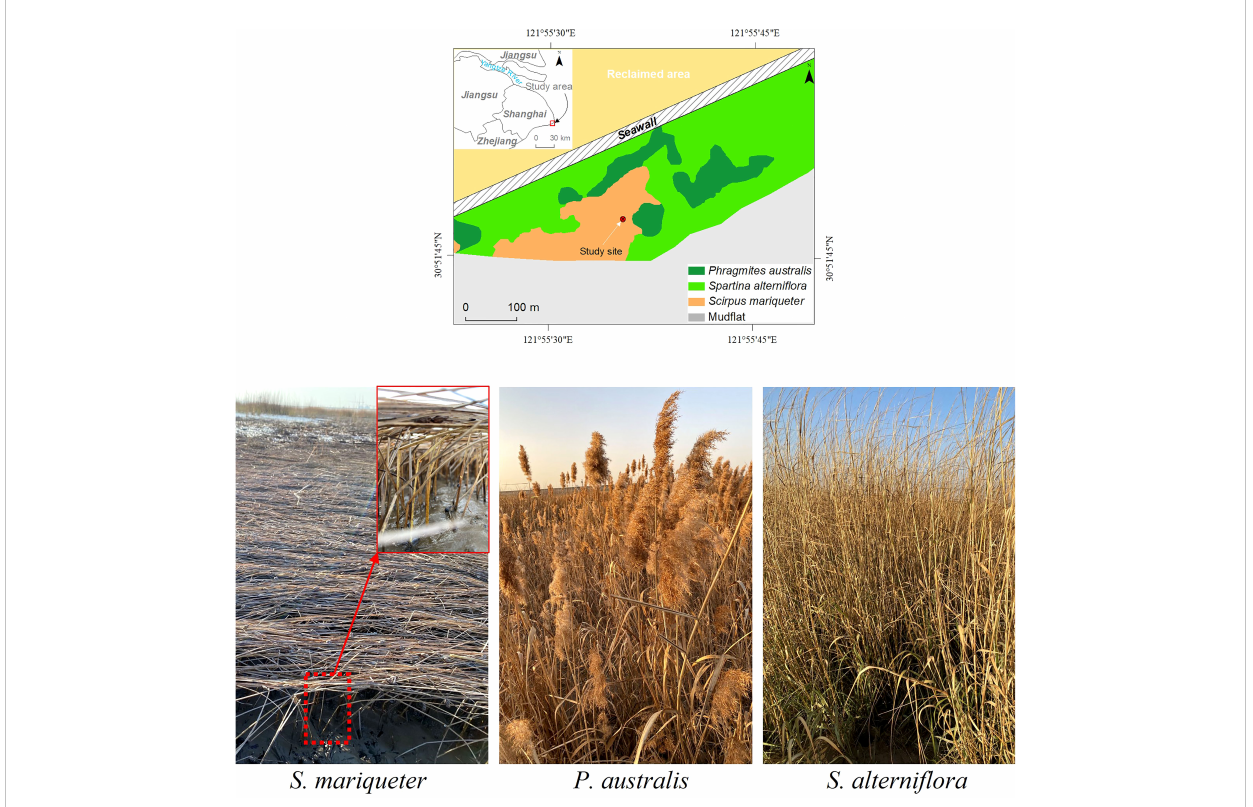
FIGURE 1 (A) Sampling site (Nanhui shore, Shanghai), (B) and photos of S. mariqueter , P. australis and S. alterni fl ora in January 2021. The S. mariqueter was fl attened and the photo in red solid square showed broken stems in red dashed